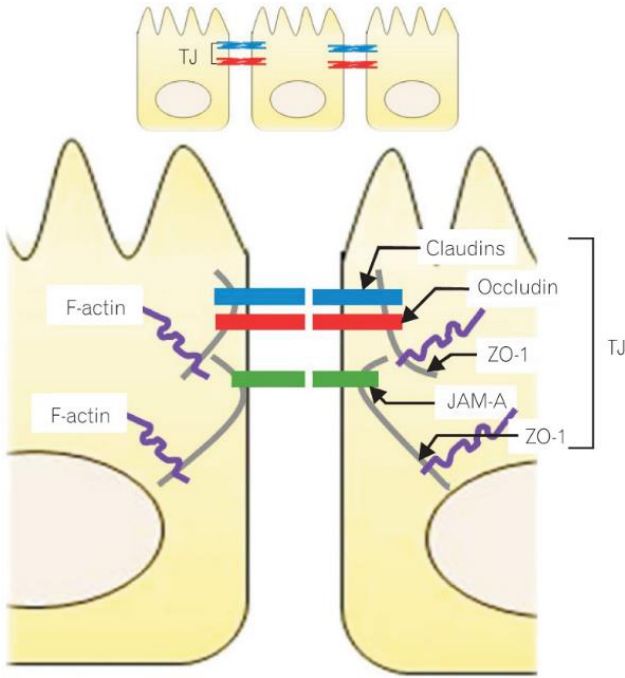
Figure 1. Molecular structure of the intracellular junction of intestinal epithelial cells. Reprinted with permission from Ref. [37]. 2015, Lee, S.H. ZO-1-zonula occludens 1; JAM-A-junctional adhesion molecule A; TJ-tight junctions